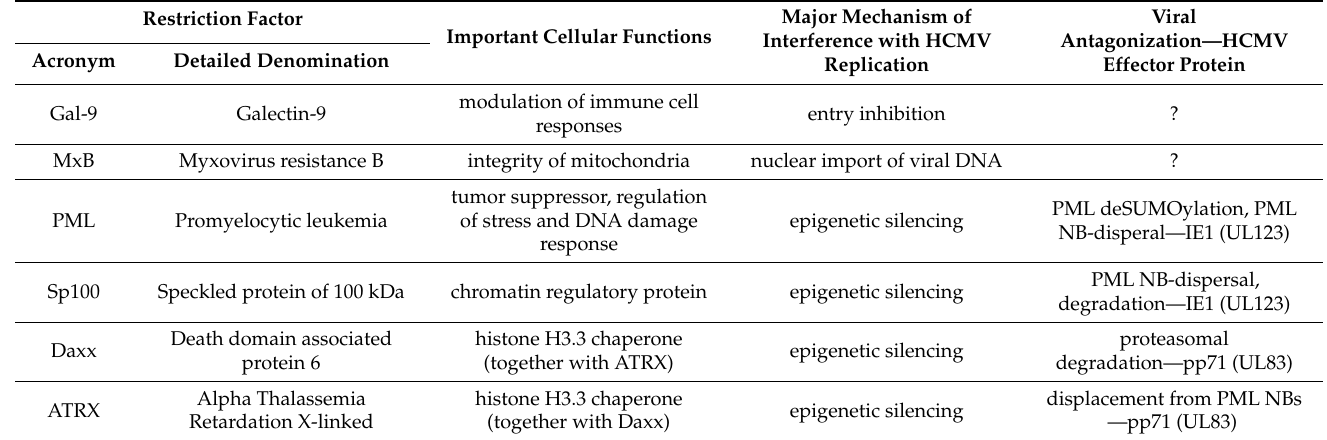
Table 1. Overview of host RFs targeting